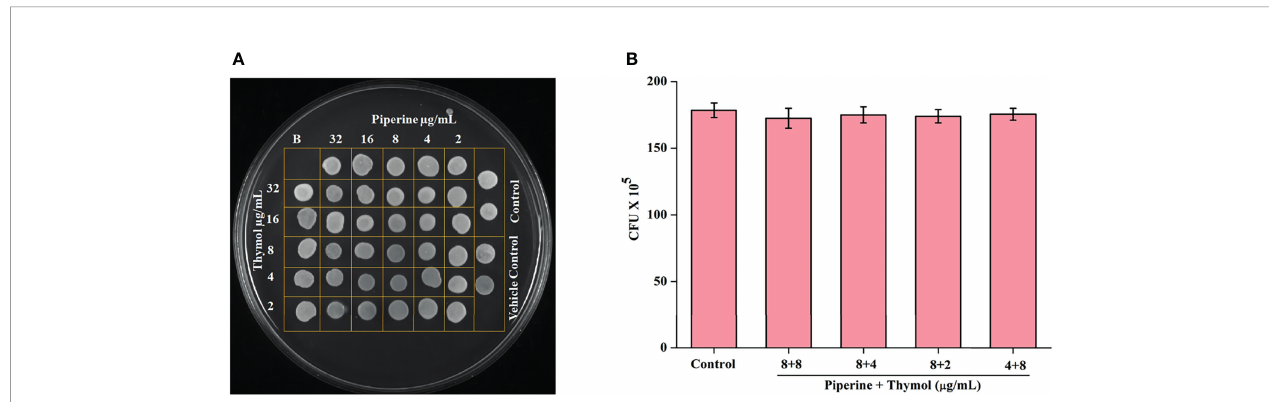
FIGURE 3 | Non-growth inhibitory effect of synergistic combinations of piperine and thymol. (A) Spot assay displaying the growth of C. albicans treated with the individual and combined activity of piperine and thymol as compared to the control. (B) Bar graph representing the number of CFU by C. albicans grown in the absence and presence of identi fi ed synergistic combinations. No signi fi cant reduction in the growth was observed.